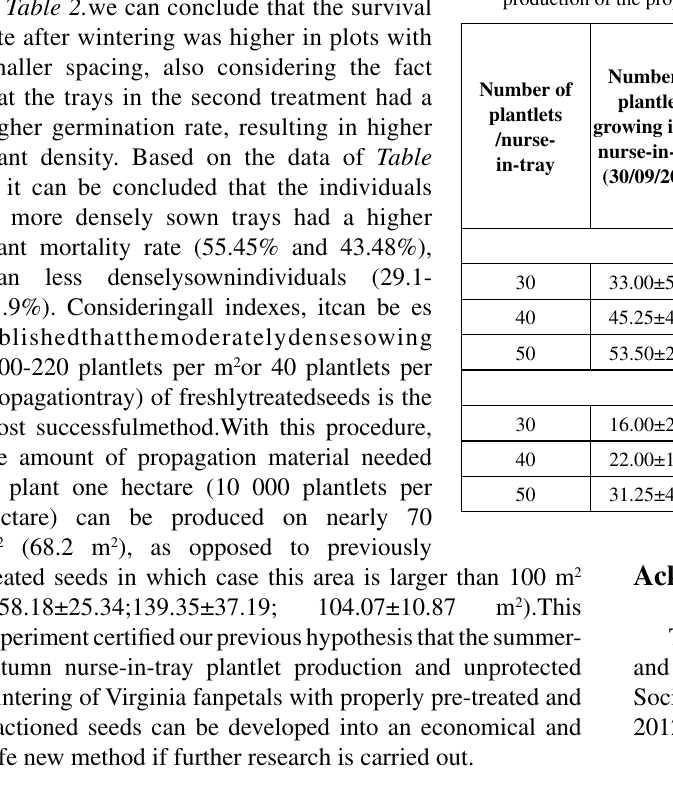
Table 2. Comparative evaluation of the efficiency of the nurse­in­tray plantlet production of Virginia fanpetals and the area demand of nurse­in­tray plantlet production needed for